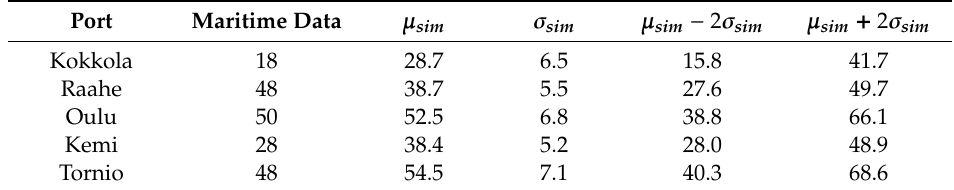
Table 4. Approximated 95% confidence interval for the simulated port-specific number of instances of IB assistance.